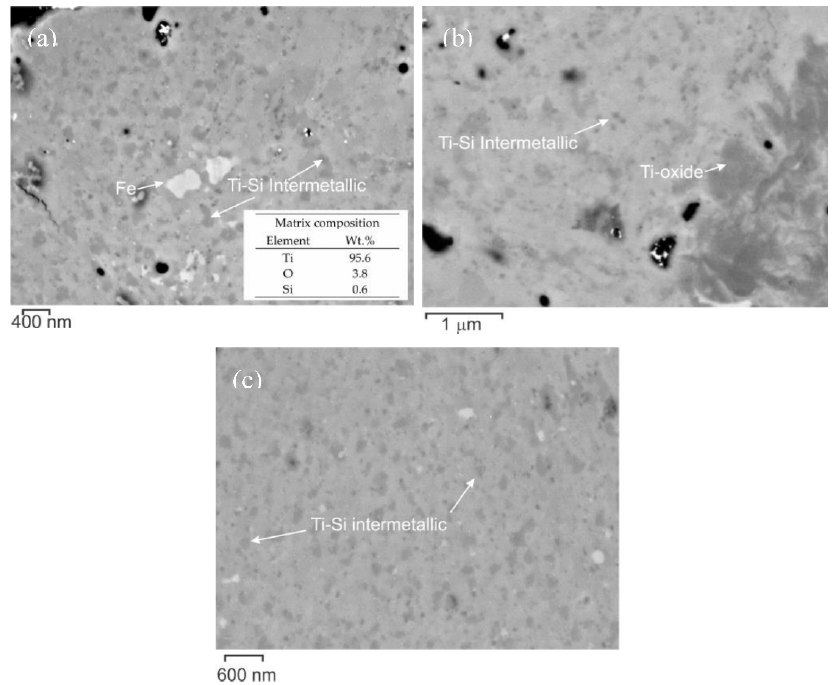
Figure 7. BSE images of the cross-sectioned heat-treated powders showing ( a ) Fe impurities; and ( b ) Ti oxide-rich zone; ( c ) other sector of the sample. The table presents the average of five EDS analyses on the matrix.